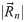
Model scheme.(a) Schematic representation of semiflexible region and actin gel in the model. (b) Magnification of three neighboring beads on the membrane plus the shaded area used for energy minimization. The faded filled circle represents the new position of the bead and defines the displacement vector |R→n|. (c, d) Stretched and compressed configurations of an attached filament exerting pulling or pushing forces on the membrane. (e) An unattached filament is bent under the membrane and exert entropic force fd.